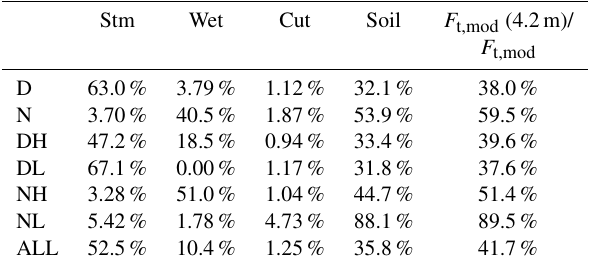
Table 3. The first four columns are the contribution fractions of different deposition pathways (stm as stomatal uptake, wet as wet skin uptake, cut as cuticle uptake, soil as soil surface uptake) in the integrated O 3 deposition flux inside the canopy in the model. The last column is the sub-canopy (below 4.2m) O 3 turbulent flux ( F t,mod (4.2m)) compared to the O 3 turbulent flux above the canopy ( F t,mod ) in the model. Different conditions are listed along the row. D and N represent daytime and nighttime and H and L rep- resent high and low humidity, respectively. ALL is for the whole